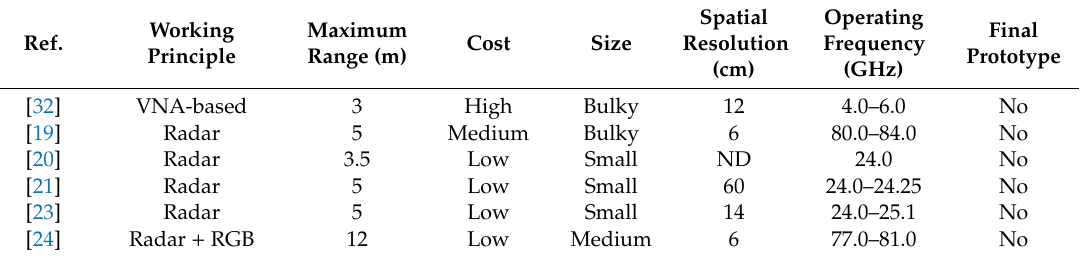
Table 1. Properties of the main electromagnetic aids for visually impaired people.